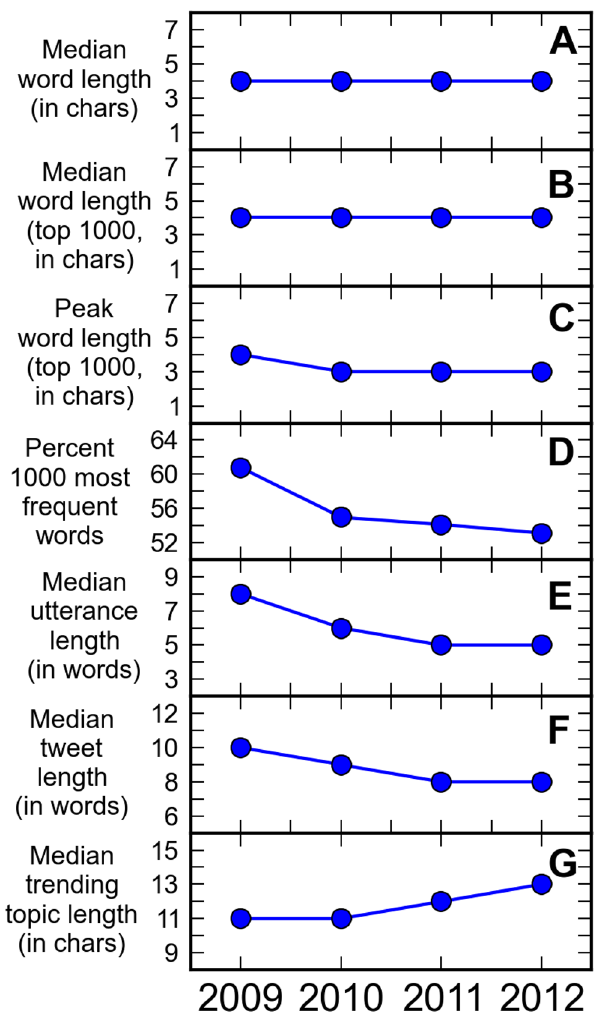
Figure 5. Exploring possible mechanisms of shortening. Annual values of A. median word length of all words, B. median word length of the 1000 most frequently occurring words, C. most frequent word length of the 1000 most frequently occurring words, D. fraction of 1000 most frequently occurring words relatively to all occurrences of words, E. median utterance length in number of words F. median tweet length in number of words, and G. median trending topic phrase length.